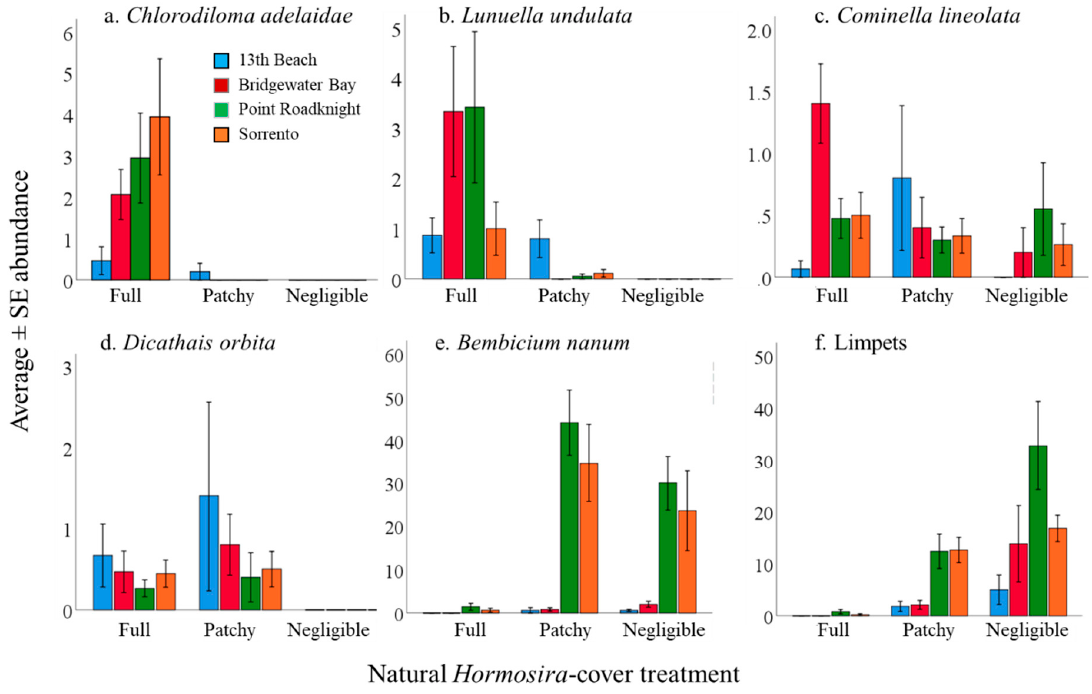
Figure 3. ( a ) Average ± SE densities of mobile invertebrates (per 0.09 m 2 quadrat) amongst natural Hormosira cover treatments for each of four sites: (a) Chlorodiloma adelaidae , ( b ) Lunella undulata , ( c ) Cominella lineolata , ( d ) Dicathais orbita , ( e ) Bembicium nanum , ( f ) Limpets ( Siphonaria spp., Cellana tramoserica , Patelloida spp. combined). N = 5 for all treatments at 13th Beach and Bridgewater Bay and N = 10 for Point Roadknight and Sorrento.